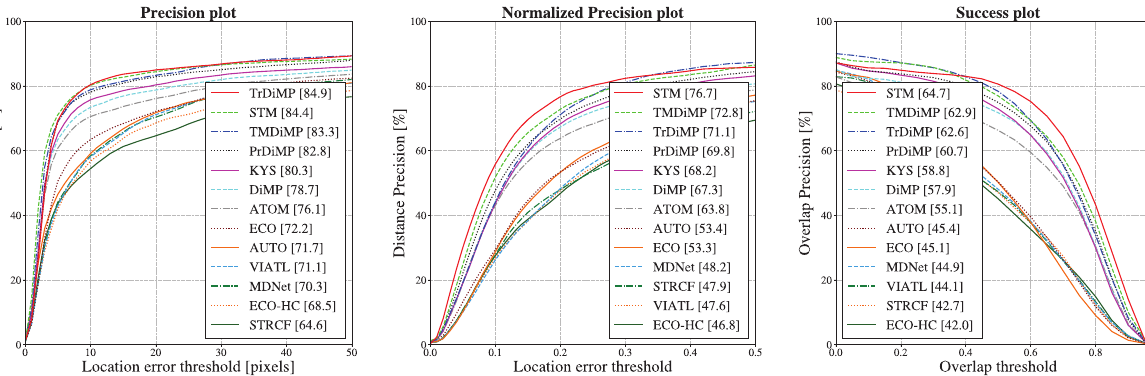
Figure 8. Precision, normalized precision and success plots of OPE on VIPUOTB.